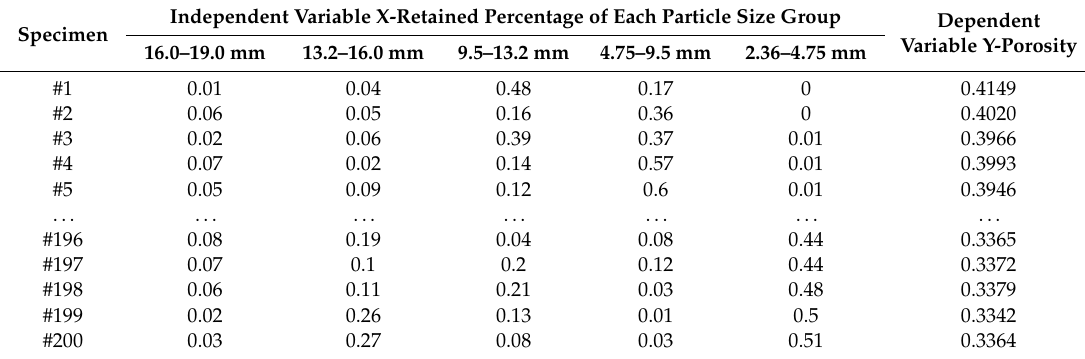
Table 7. Recorded data of